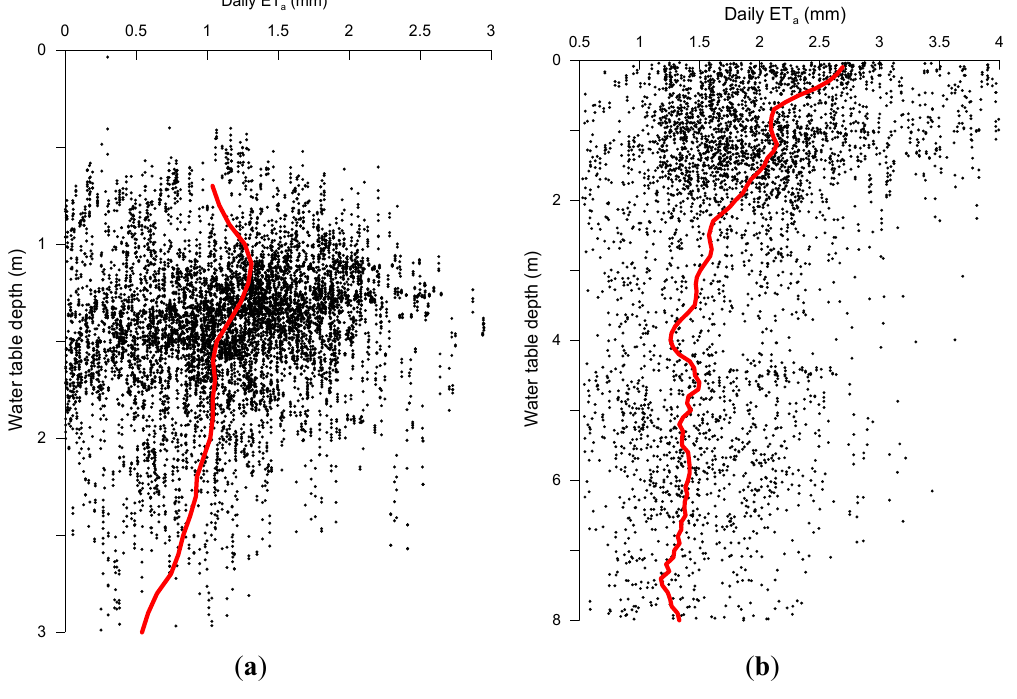
against water table depth in ( a ) WTM and a